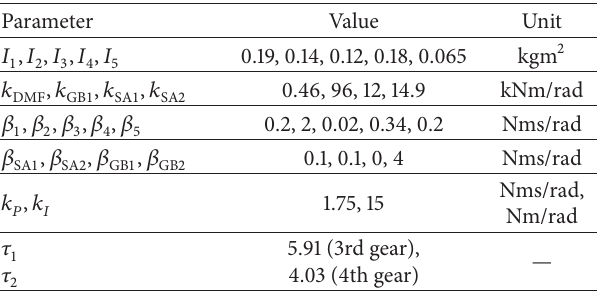
Table 2: Numerical values of the model parameters.